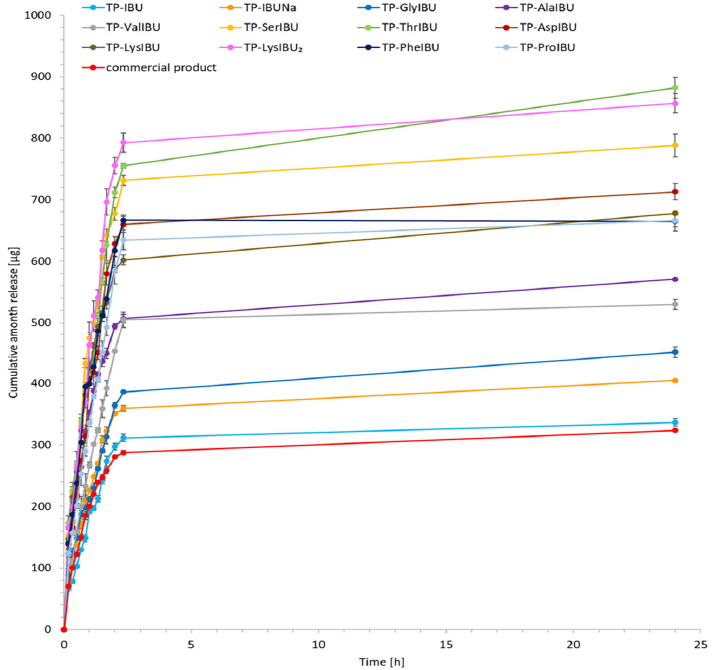
Figure 9. Time course of the cumulative mass of IBU and its derivatives during the 24 h release (mean ± SD, n = 3).